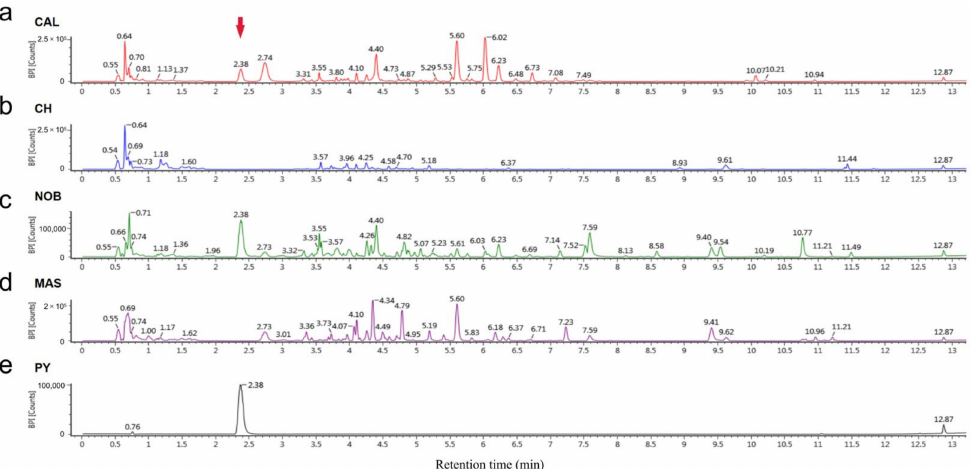
Figure 5. HPLC chromatograms of wine and pyrogallol solution. ( a ) CAL; ( b ) CH; ( c ) NOB; ( d ) MAS; ( e ) Pyrogallol. HPLC separation: reversed phase C18 column (2.1 mm × 100 mm × 1.7 µ m); temperature: 45 ◦ C; phase A: 0.1% formic acid solution; phase B: 0.1% formic acid—acetonitrile solution; flow rate: 0.4 mL/min. MS source temperature: 450 ◦ C; ionspray voltage: 2 kV, flow rate: 15 L/min, scan range: 50–1000 m / z